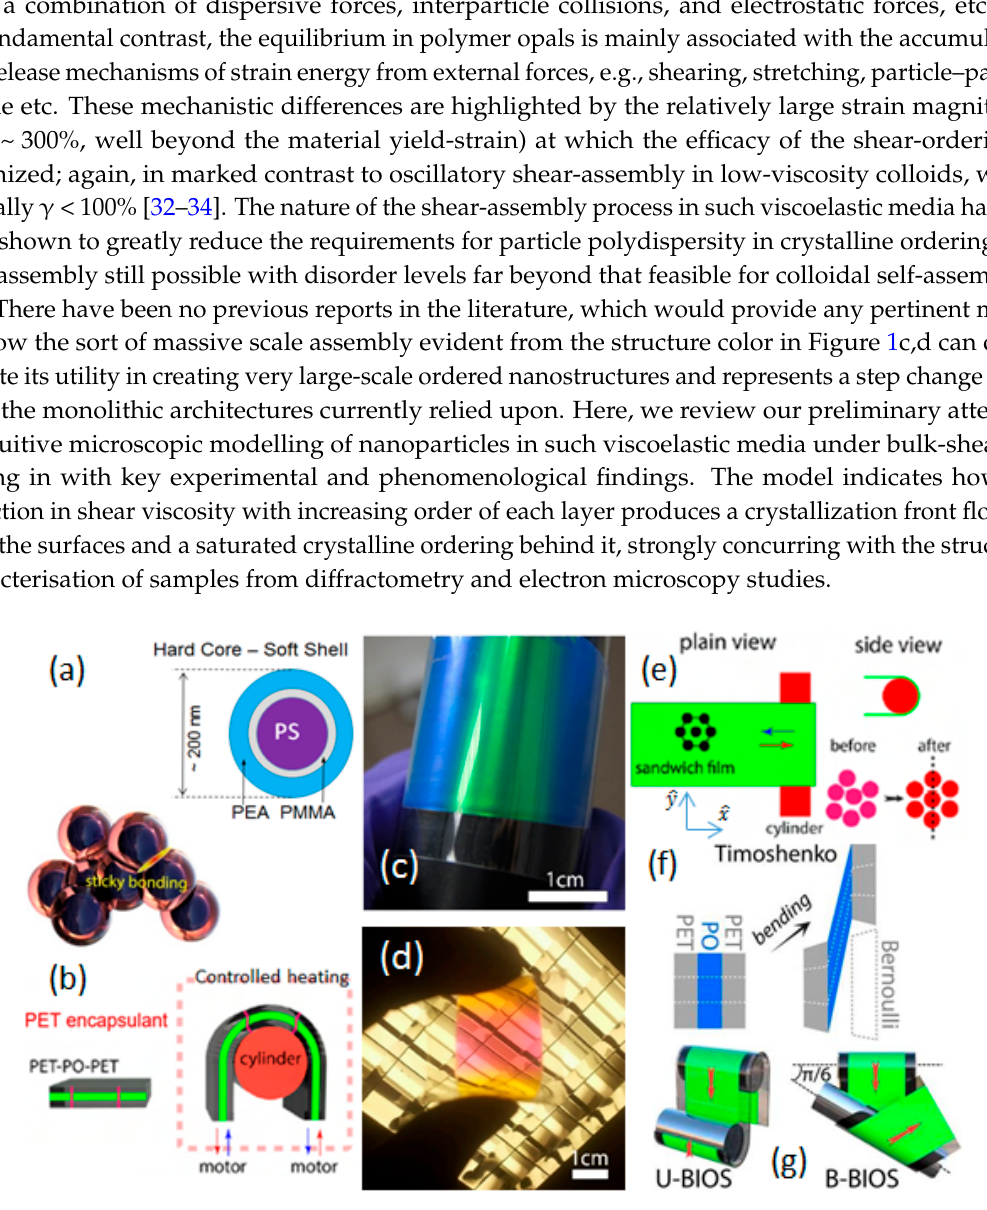
Figure 1. ( a ) Core–shell architecture of precursor particles for viscoelastic assembly, showing the hard-core (polystyrene, PS), grafting layer (poly-methyl methacrylate, PMMA) and soft-shell (poly-ethylacrylate, PEA) components, which have a short-range “sticky bonding” interaction; ( b ) illustrates the mechanics of Bending-induced Oscillatory Shear (BIOS), with the polymer opal (PO) thin-film layer encapsulated by rigid polyethylene terephthalate (PET) tapes; ( c , d ) show photographic images of the resultant polymer opal films in reflected and transmitted white light respectively; ( e ) illustrates the principle of ensemble ordering as an oscillatory bending shear is applied; ( f ) Mechanism of BIOS inside the PET–PO–PET “Timoshenko sandwich”, with the dashed white lines indicating the bending-induced deformation in different layers; ( g ) shows the geometry and shear-processing direction of uniaxial U-BIOS (left) and biaxial B-BIOS (right) as indicated by arrows, in consistency with the conventions shown in ( b , e ). (Adapted from Ref. [28] with permission of Nature Publishing Group).